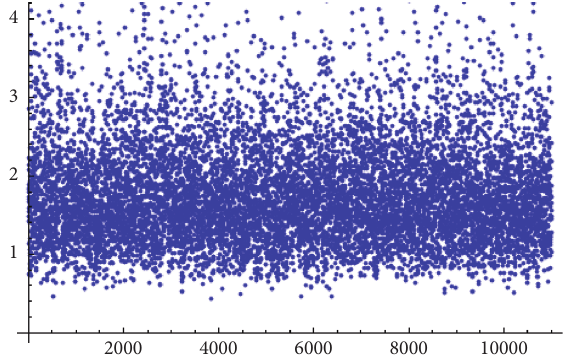
Figure 7: Simulation number of β generated by the MCMC method.